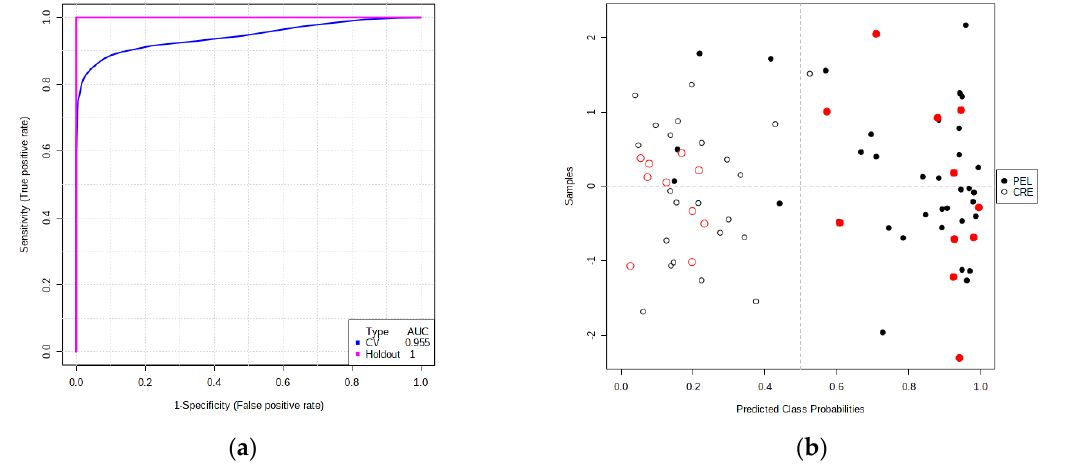
Figure 6. ( a ) ROC curves from the combination of the potential biomarkers for the cross − validation (blue — CV) and external validation set (pink — hold-out). ( b ) Plot of the average predicted class probabilities for each olive oil sample from the Peloponnese (solid dots) and Crete (open dots). The red dots (solid and open) denote samples belonging to the external validation set. The classification boundary is located at the center (x = 0.5, the dotted line) because the algorithm uses a balanced sub-sampling